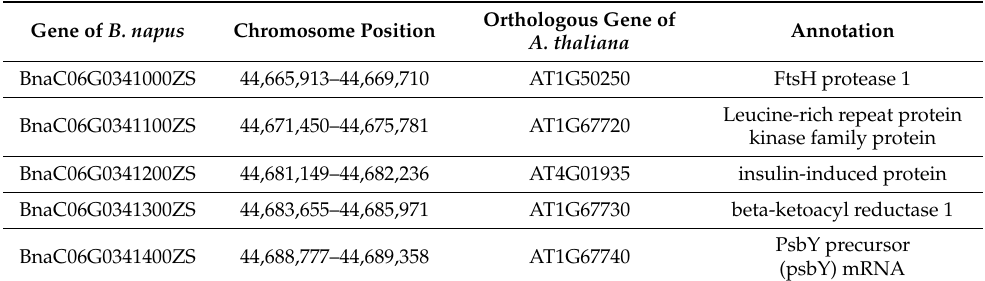
Figure 3. Fine mapping and functional confirmation of BnaC06.FtsH1 in rapeseed. ( a ) Initial mapping of CYD 1 using 8777 etiolated-cotyledon individuals from the selfing segregation population of 7-521. The applied markers are marked above the chromosome, and the number of recombinants in this population is marked below. ( b ) Fine mapping of CYD1 using 15,167 etiolated individuals. The numbers indicate the number of recombinants. ( c ) Annotation in 29K region according to the ZS11 ( Brassica napus cultivar) reference genome. The red box indicates the candidate genes predicted in ZS11 database. ( d ) Confirmation of the BnaC06.FtsH1 function using the expression of BnaC06.FtsH1 in 7-521Y. The phenotype of the T 0 transgenic plants returned to normal. ( e ) Identification of the T 1 transgenic seedlings using PCR. A3-4-G, normal individuals from the A3-4 T1 population; A3-4-Y, etiolated individuals from the A3-4 T1 population; N, negative control from 7-521Y; P, positive control from vector plasmid; M, molecular markers. Bars: ( d ) 4 cm; ( e ) 5 mm. Table 1. Prediction and annotation of candidate genes within the mapping